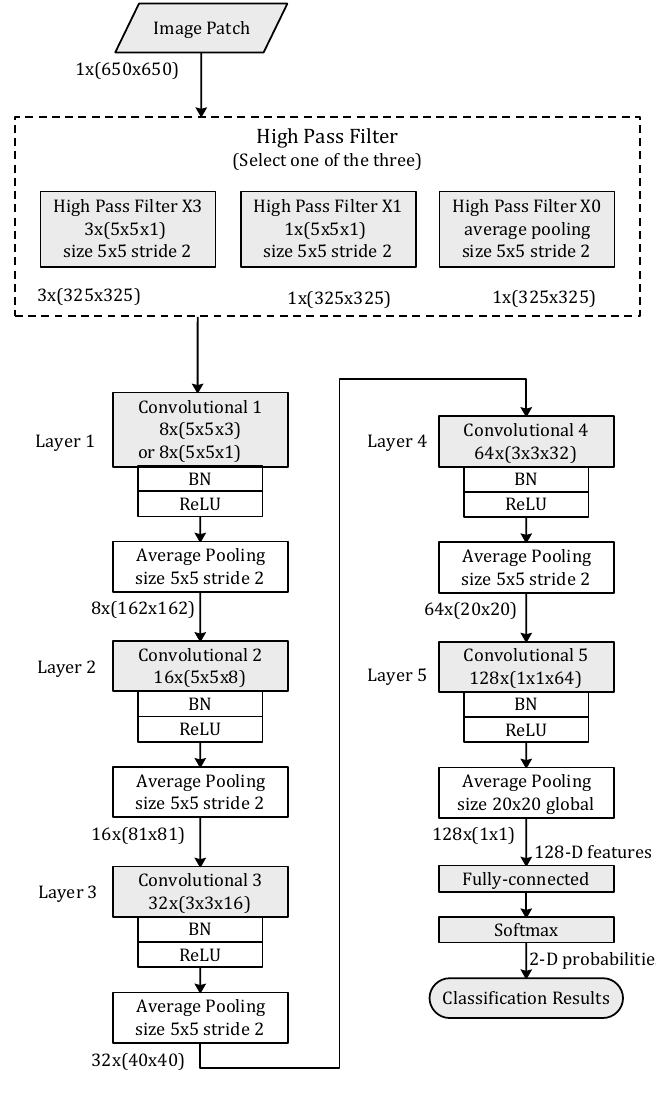
Figure 3. The proposed convolutional neural network architecture. Names and parameters of each layer are displayed in the boxes. Kernel sizes in each convolution layer are shown as number _ of _ kernels × ( width × height × number _ of _ input ) . Sizes of feature maps between consecutive layers are shown as number _ of _ feature _ maps × ( width × height ) . Padding is used in each convolutional layer to keep the shape of image patches. BN: batch normalization; ReLUs: rectified linear